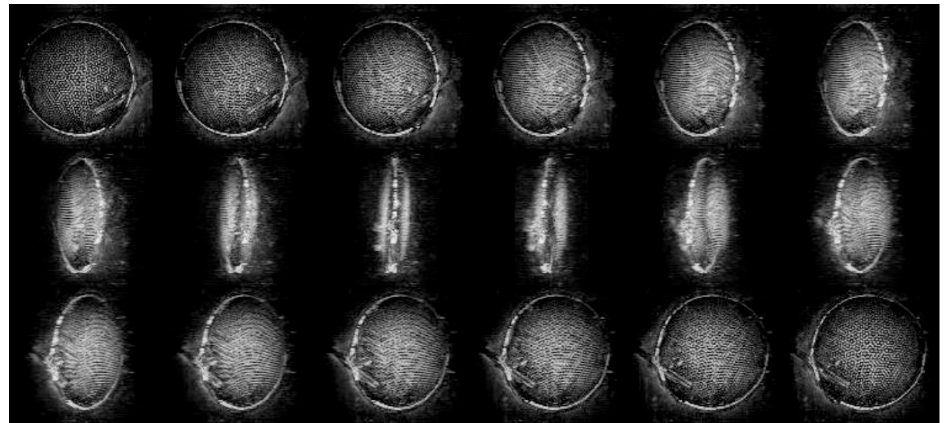
Figure 3. A 3D view of a Coscinodiscus sp. diatome using tomographic diffractive microscopy (TDM) with Born approximation. The pictures depict an 18-step, 0°–180° rotation of the specimen [41].